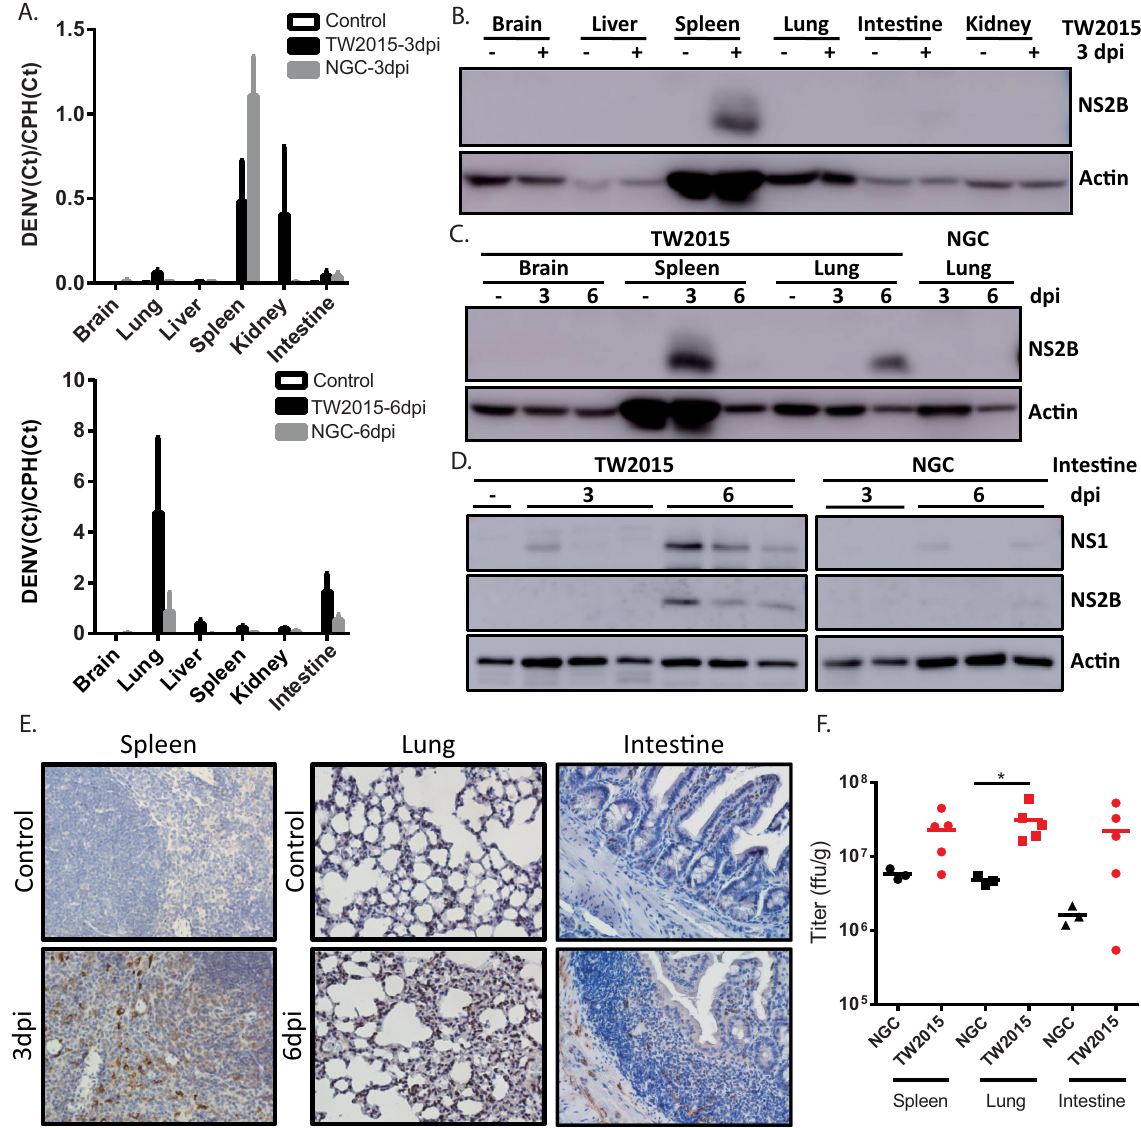
Fig 2. The TW2015 virus showed robust replication in mouse spleen and disseminated to additional organs. (A) Quantitative RT-PCR of organ samples (collected at 3 or 6 days post-infection [dpi]) from AGB6 mice infected with the NGC or TW2015 virus (iv, 10 5 pfu/mouse) using specific primers for dengue virus (DENV) and the housekeeping gene cyclophilin (CPH). (B-D) DENV viral protein expression in mouse tissue collected at 3 or 6 dpi via immunoblotting with an anti-NS2B antibody. (E) Immunohistochemical staining of tissue sections from the TW2015-infected mice with an anti-NS3 antibody. (F) Virus titers in the infected mouse organs collected at 5 dpi were measured. tissue was below the limit of detection (Figs 2C and S1). The TW2015-infected tissue sections were also stained with an anti-DENV NS3 antibody (Fig 2E). The TW2015-infected cells were found in the red pulp of the spleen at 3 dpi. Viral protein was expressed in some alveoli of the lung tissue at 6 dpi. In the small intestine, NS3-positive staining was mainly observed in the submucosa and lamina propria at 6 dpi. Inflammation occurred in the TW2015-infected small intestine as indicated via immune cell infiltration at 6 dpi (Fig 2E). Infectious viruses could be recovered from the DENV-infected spleen, lung, and small intestine (Fig 2F). The virus titer was significantly higher in the TW2015-infected lungs than in the NGC-infected lungs. Taken